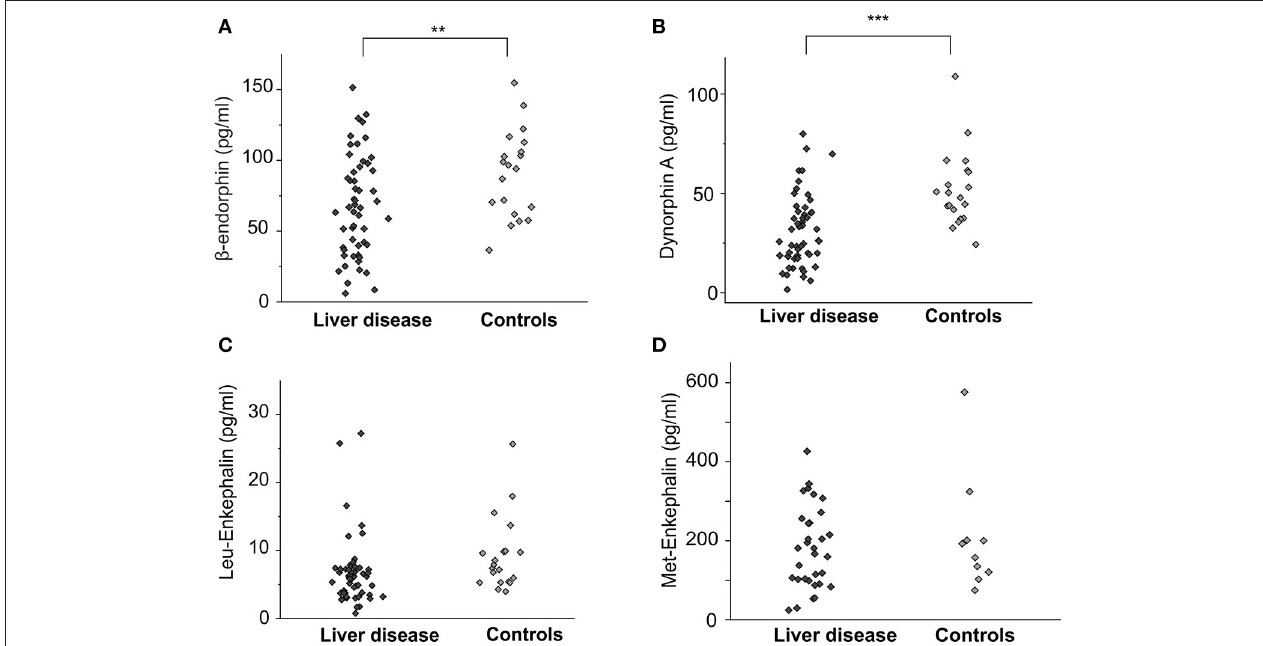
FIGURE 1 | Endogenous opioid plasma levels in patients with cholestatic liver diseases and healthy controls. Concentrations [pg/ml] of β -endorphin, dynorphin A, Leu-enkephalin and Met-enkephalin of patients with cholestatic liver diseases ( n = 56, dark gray diamonds) and age- and gender matched controls ( n = 20, light gray diamonds) are shown as individual values in (A–D) . Significantly lower levels of both β -endorphin (A) and dynorphin A (B) were observed in the patient group. The difference for Leu-enkephalin was not significant (C) . Data were statistically analyzed by multi-way analysis of variance (ANOVA) with least significant difference (LSD) post hoc testing. Significant differences are indicated by asterisks: ** p < 0.01, *** p <